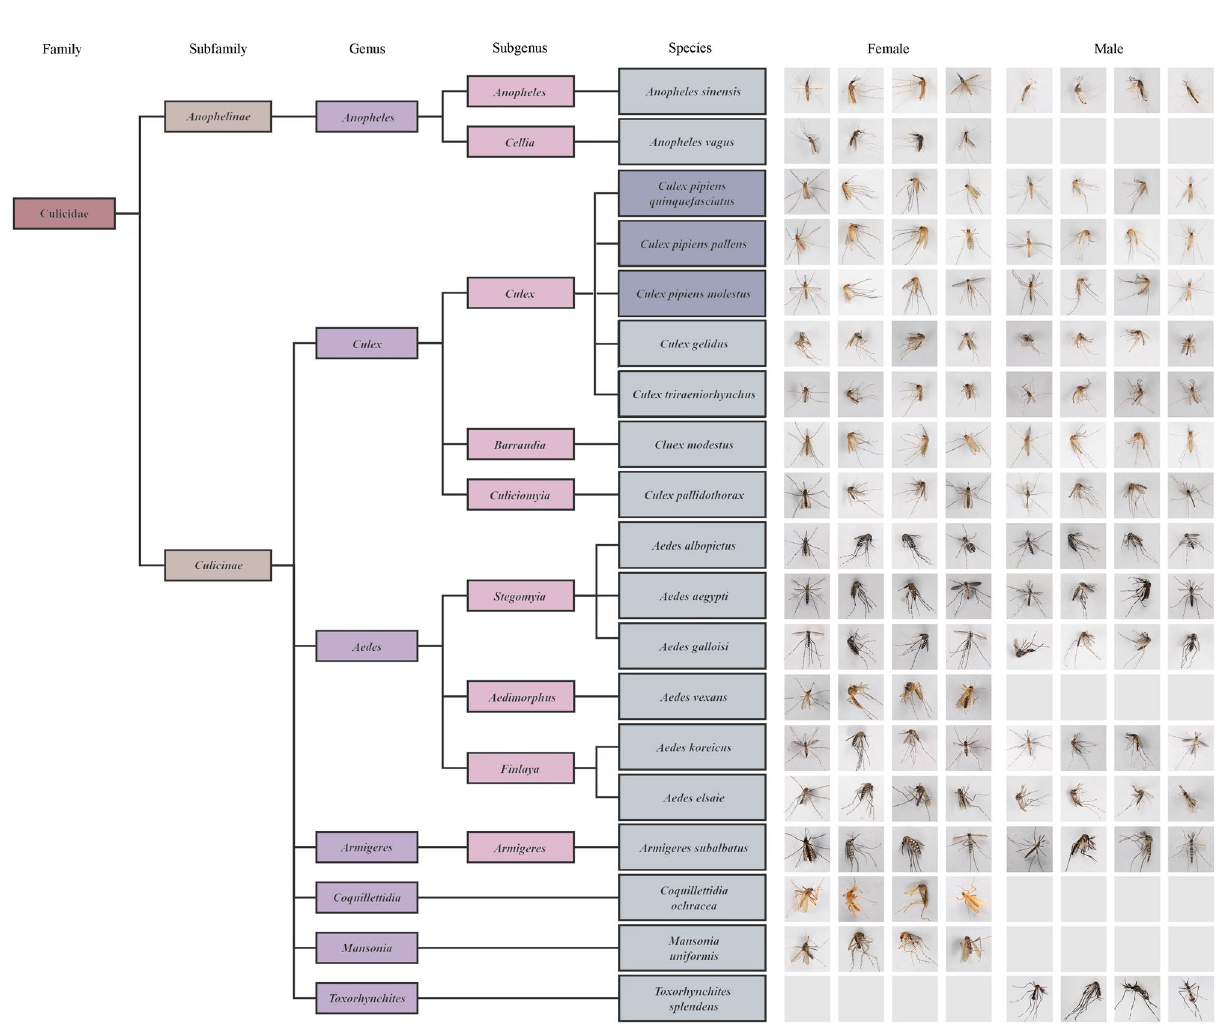
for 5 species, each mosquito includes 300 images of both sexes, and the resolution of mosquito photos were 4464 × 2976. Cx. pipiens quinquefasciatus , Cx. pipiens pallens , and Cx. pipiens molestus (subspecies level, in dark gray background) were 3 subspecies in Cx. pipiens Complex (species